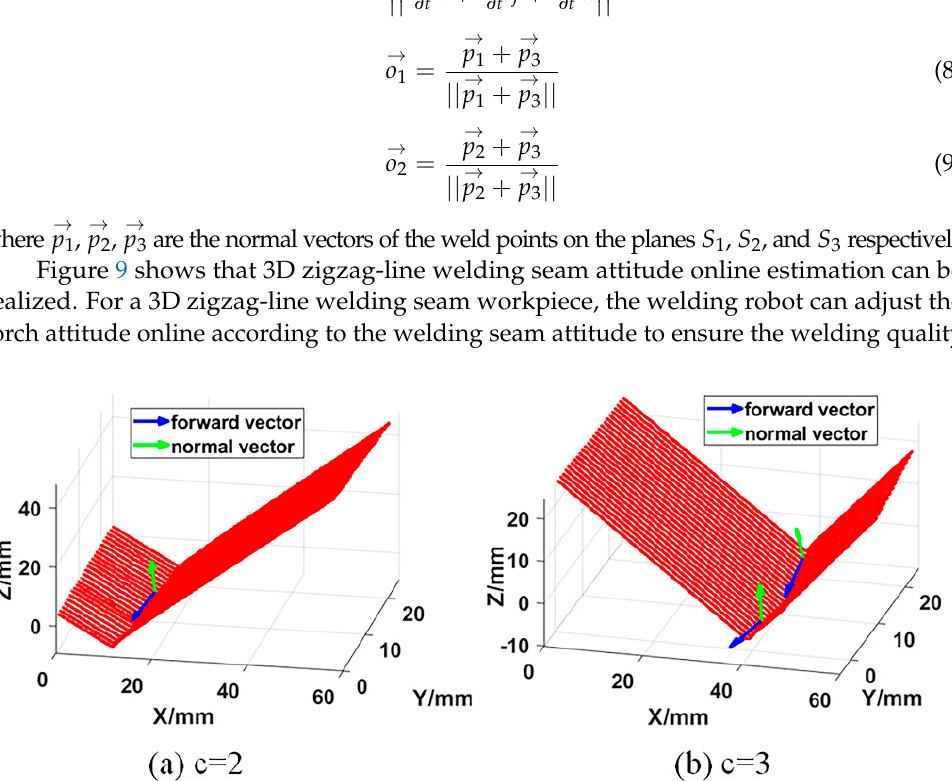
Figure 9. Welding seam attitude estimation results; ( a ) When c = 2, the welding seam attitude estimation result; ( b ) When c = 3, the welding seam attitude estimation result.